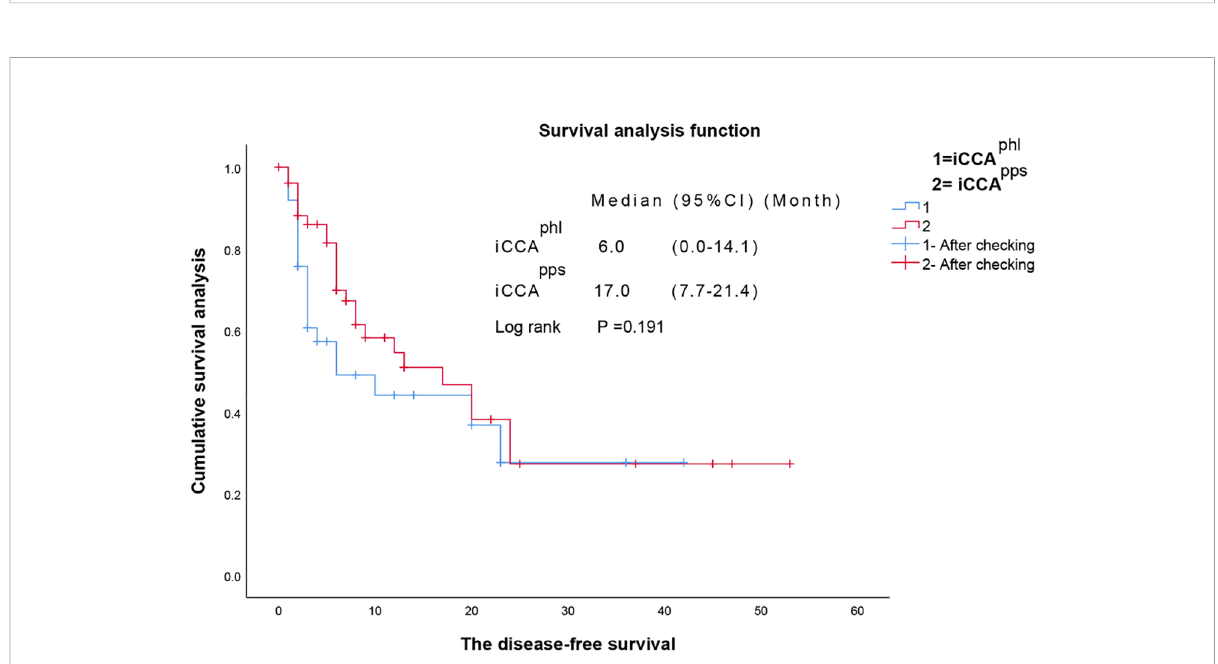
FIGURE 4 Pairwise comparison of the disease-free survival between the two types of intrahepatic cholangiocarcinoma. iCCA phl , perihilar large duct type of intrahepatic cholangiocarcinoma; iCCA pps , peripheral small duct type of intrahepatic cholangiocarcinoma; CI, con fi dence